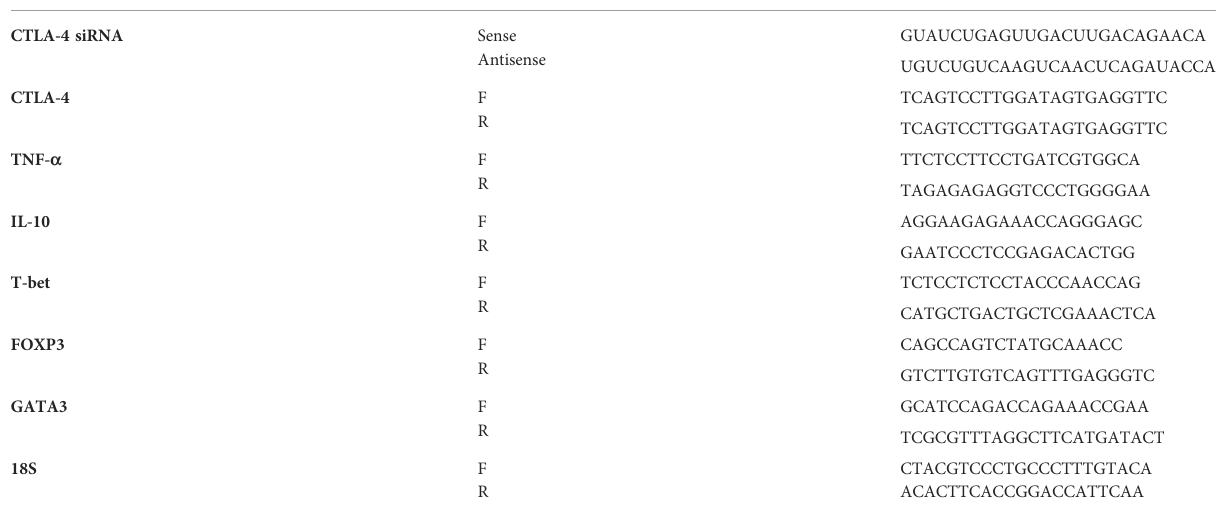
Table 1. List of primer sequences and